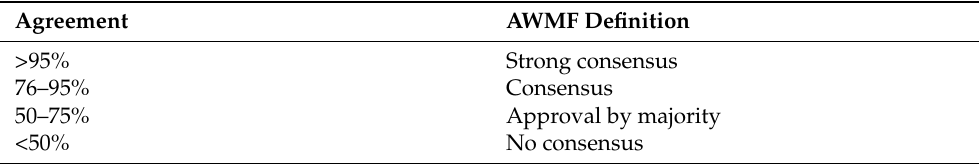
Table 4. Classification of strength of consensus according to AWMF rules and standards [19].